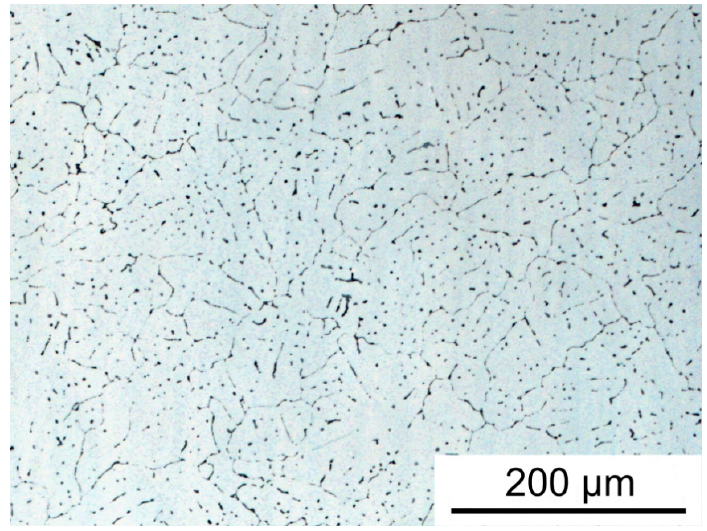
Figure 1. Structure of as-cast grains and intermetallic phase cast rod, which is non-homogenized.